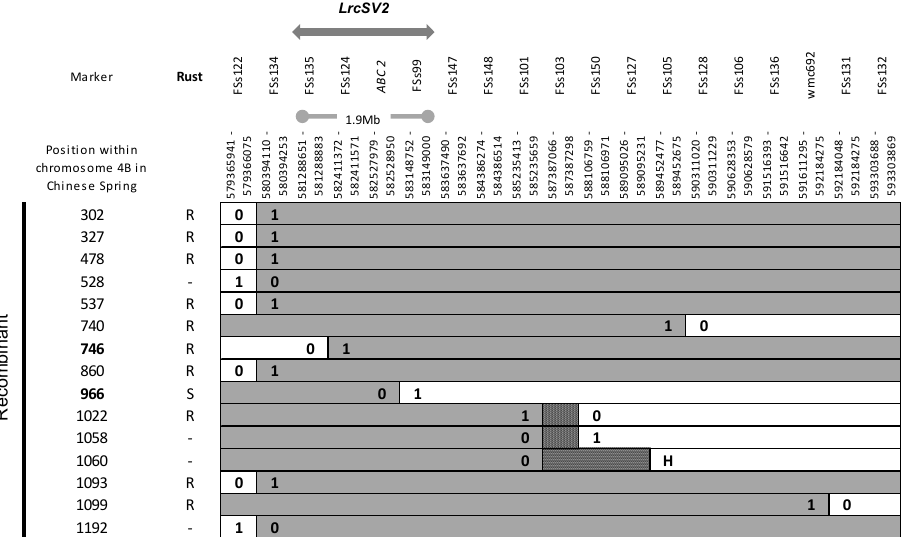
Figure 4. Graphical genotype table of recombinants found between FSs122 and FSs132 markers. Due to missing data in recombinants 1022, 1058 and 1060, possible crossover positions are denoted with hatched cells. Markers positions on the Chinese Spring chromosome 4B IWGSC RefSeq v2.1 is shown. Recombinants for the minimal interval containing the LrcSV2 gene are depicted in bold. 0 susceptible Purplestraw genotype, 1 resistant Sinvalocho genotype, H heterozygote genotype. Rust: Artificial infection with P. triticina race Ca02G1R at adult plant stage, R resistant phenotype, S susceptible phenotype.